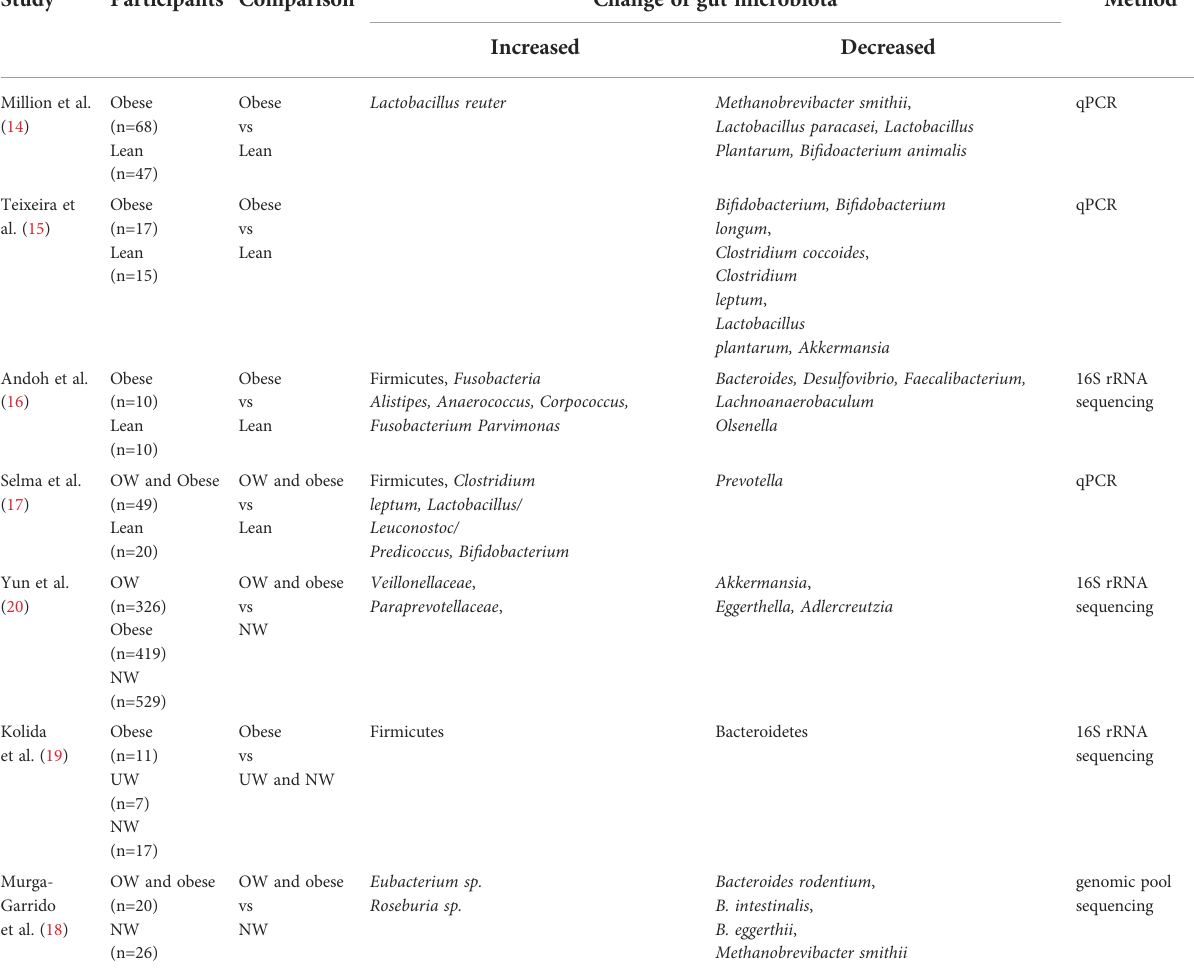
TABLE 1 Alterations of gut bacteria associated with obesity in